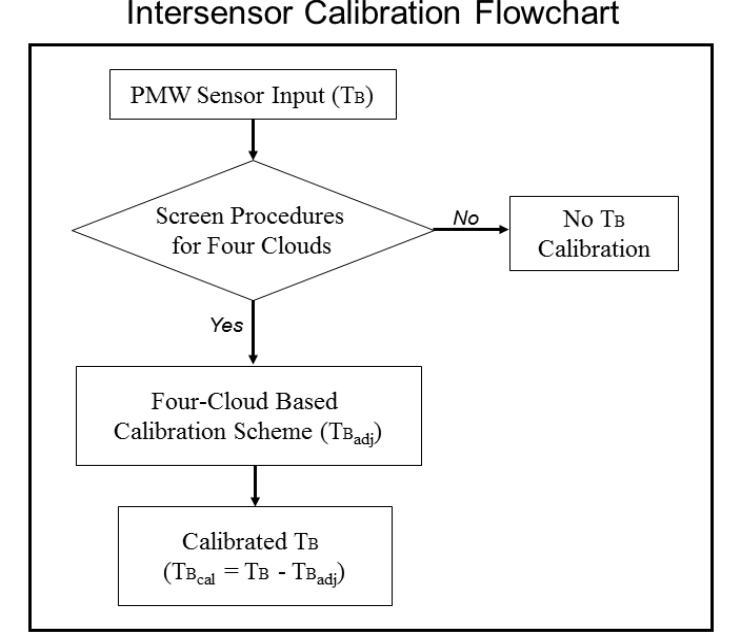
frequency calibration B